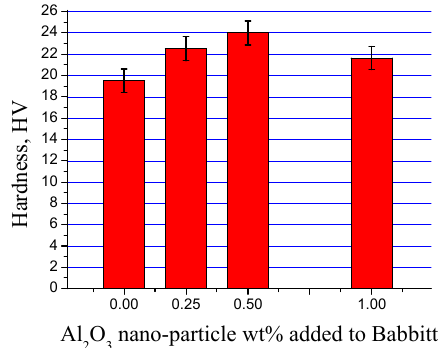
Figure 9. Hardness values of tin-based Babbitt alloy nanocomposite containing alumina nanoparticles.